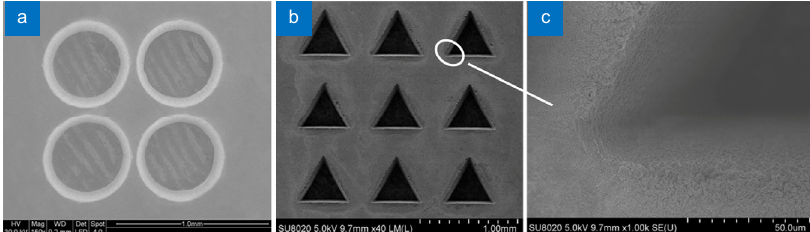
Fig. 13 | SEM micrograph. ( a ) Circle micro-through-hole array. ( b ) Triangle micro-through-hole array. ( c ) Enlarged image of tip angle of the triangle micro-hrough-hole. Figure reprinted with permission from ref. 76 , Springer-Verlag, Berlin Heidelberg.